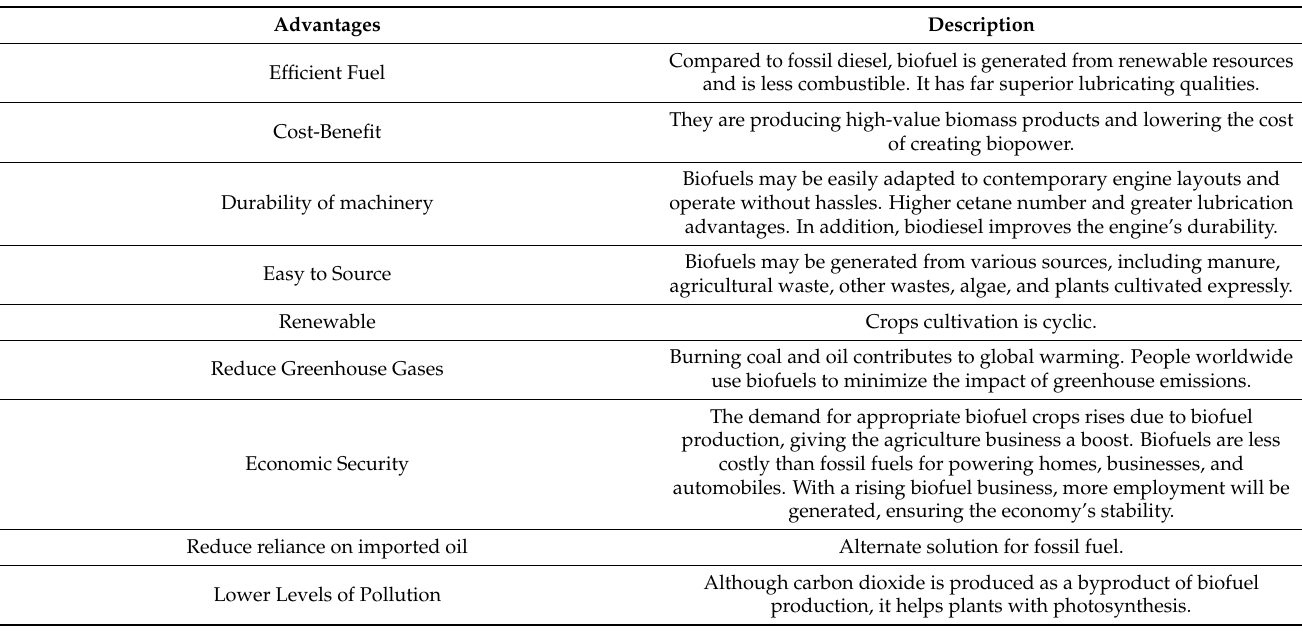
Table 2. Advantages of biofuels over fossil fuels.